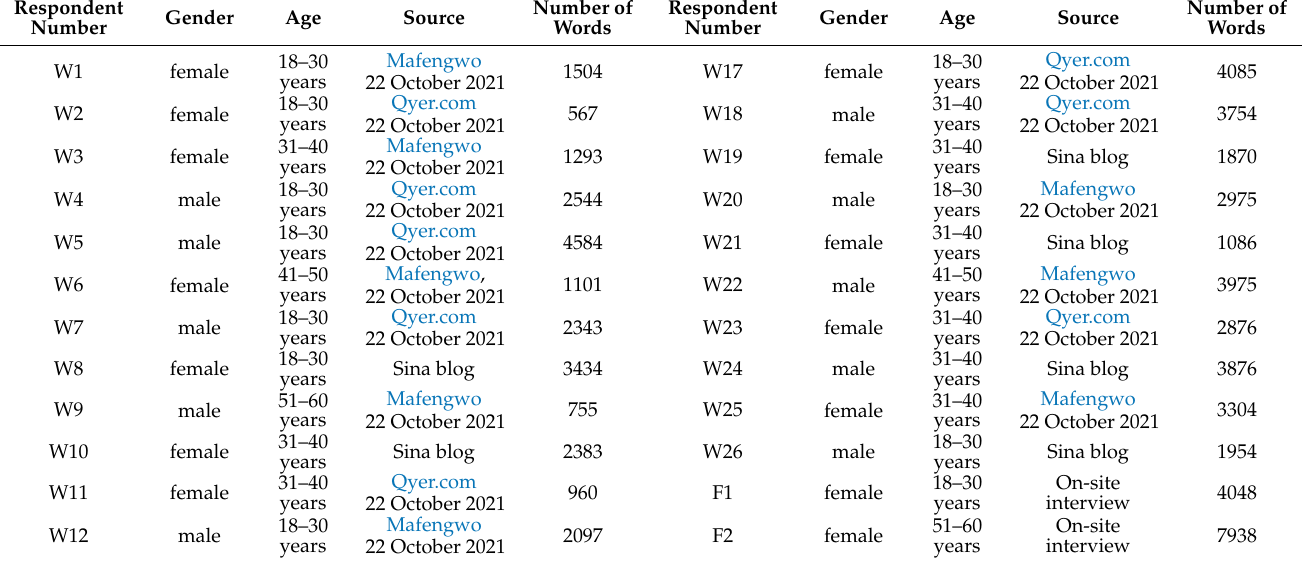
Table 1. Basic sample